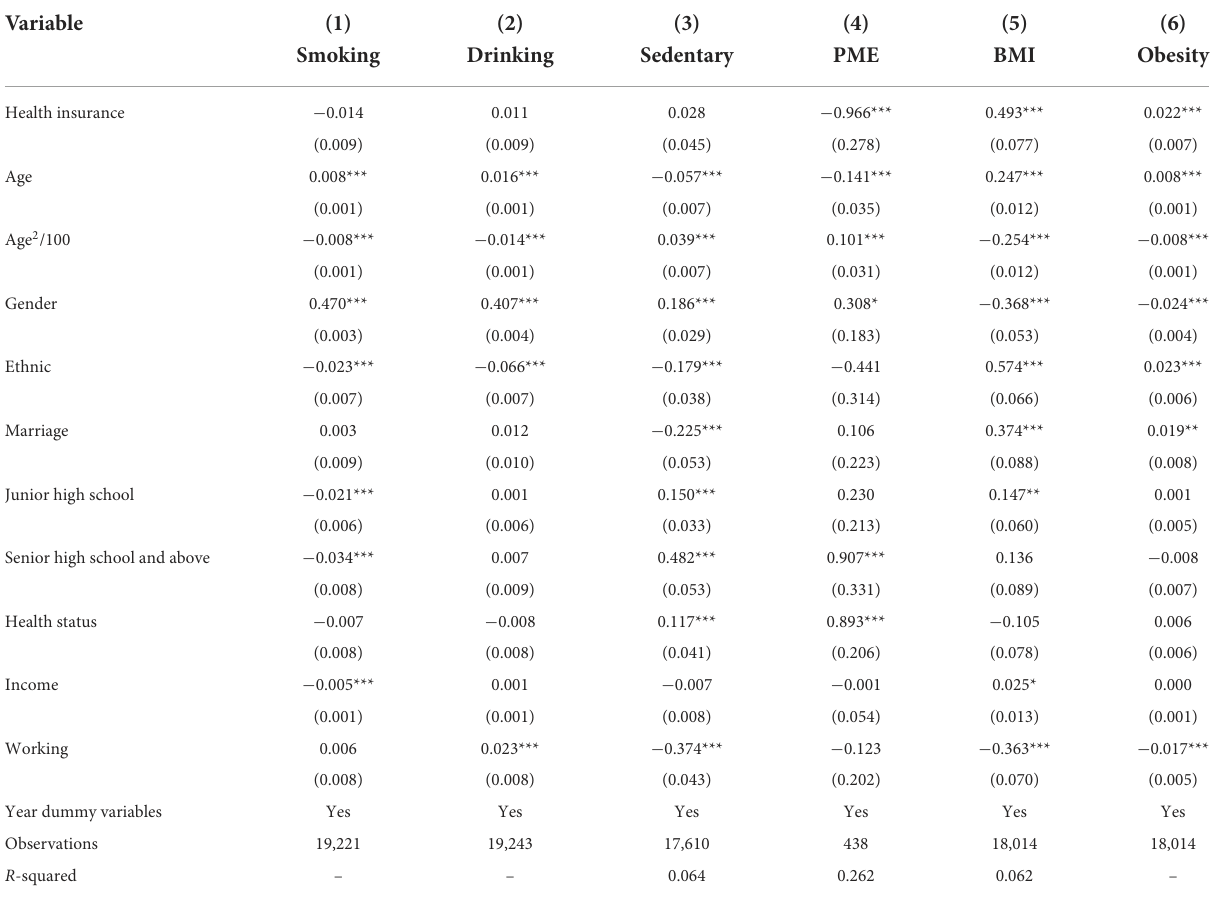
TABLE 3 Benchmark regression results (Probit and